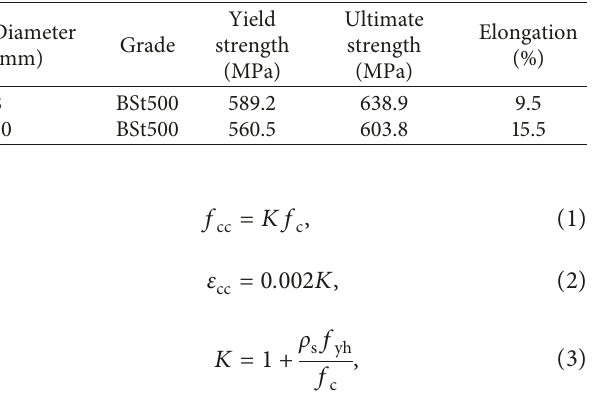
Table 2: Steel mechanical properties.